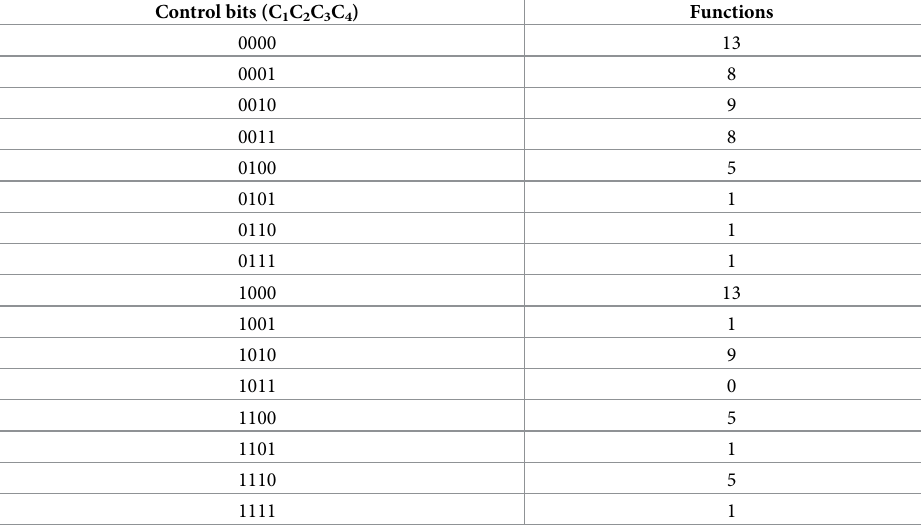
Table 1. The instruction set of a single fabricated NLDBM logic